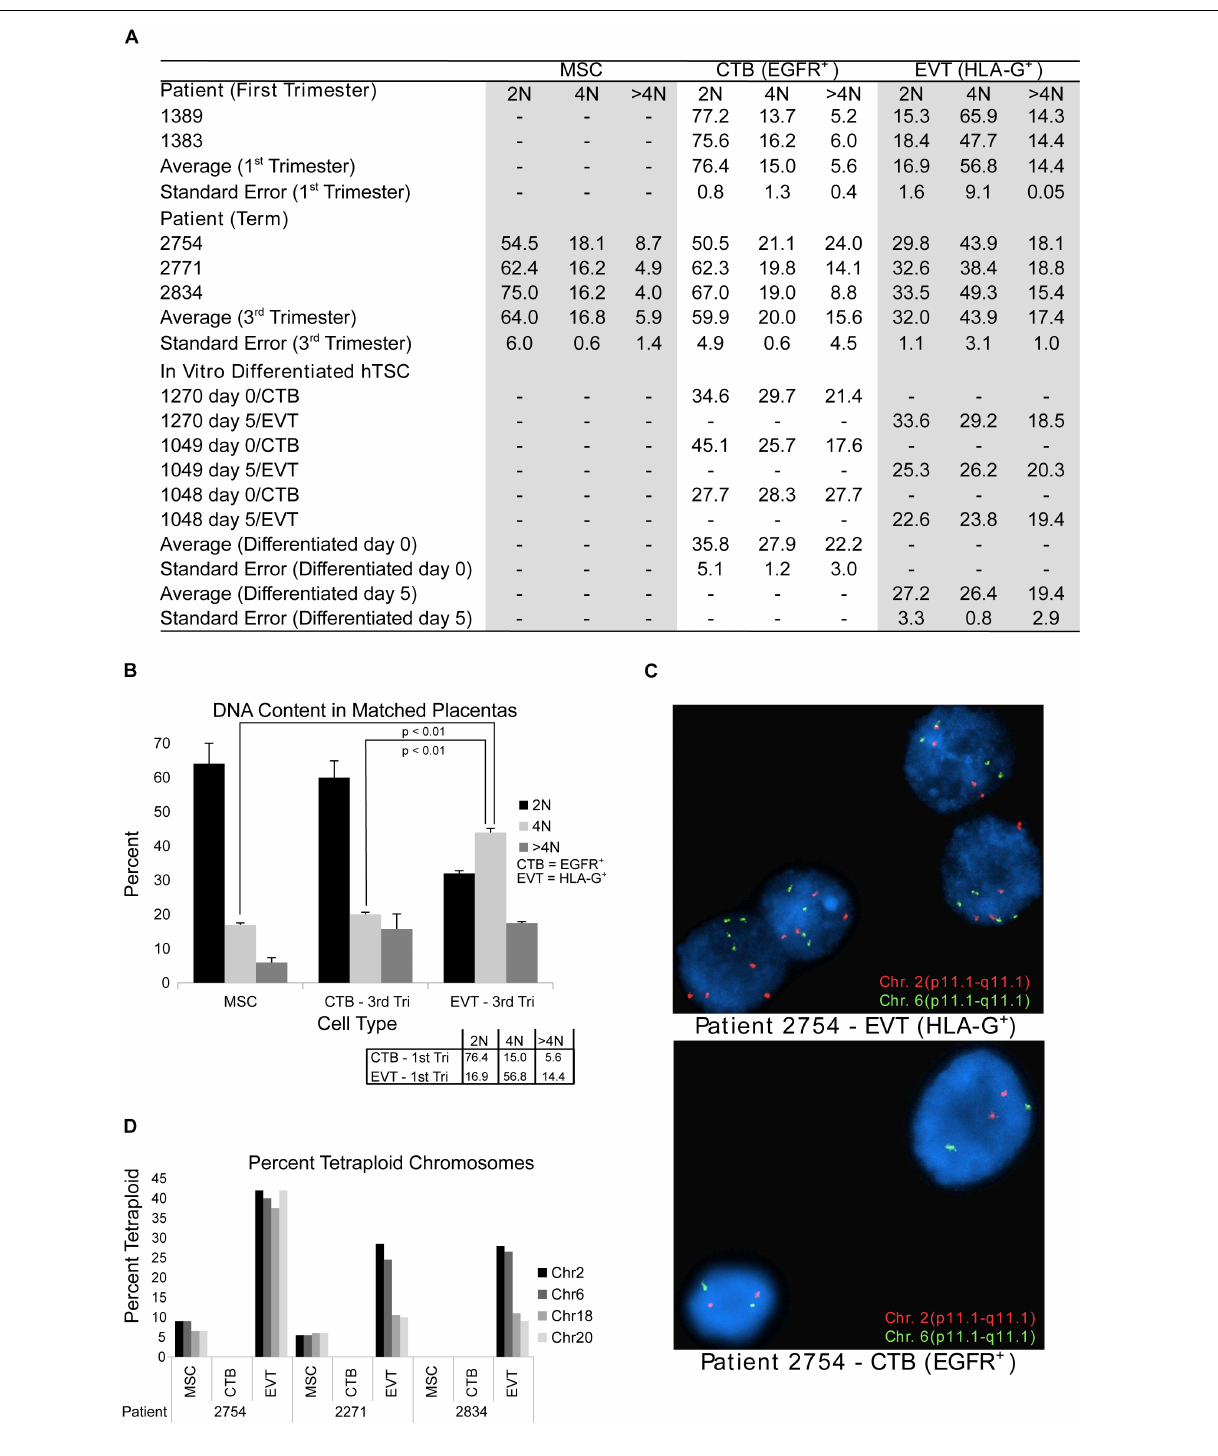
Frontiers in Cell and Developmental Biology |